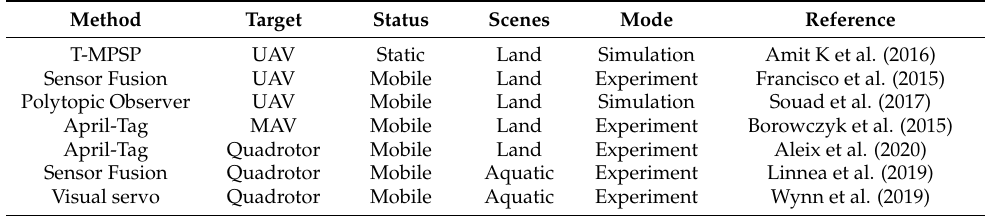
Table 1. Aircraft landing